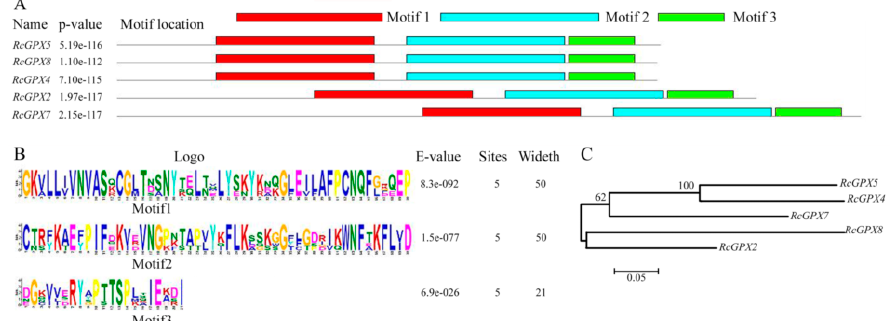
Figure 2. Architecture and phylogenetic tree of glutathione peroxidases of Rhodiola crenulata . The structures of RcGPXs were predicted by MEME software. Distribution of conserved domains was presented by different colors ( A ). Hidden Markov model logos obtained using MEME ( B ). The phylogenetic tree of RcGPXs was constructed using the neighbor-joining method of CLUSTALW by Mega 5.0, with 1000 bootstraps, and the bar indicates 0.05 substitutions per site. Each ellipse shows a clade ( C ).